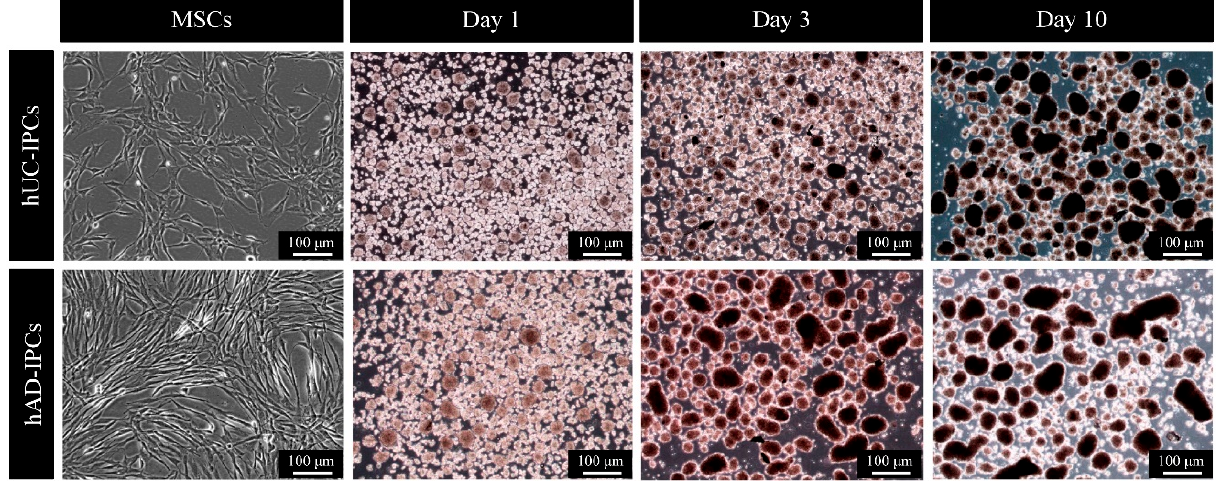
Figure 2. Induction of cultured hUC-MSCs and hAD-MSCs into IPCs using a modified insulin– transferrin–selenium protocol. IPCs differentiation were induced in three steps over 10-day. Each step was marked by a change in medium composition. The differentiation of IPCs from hUC-MSCs (hUC-IPCs) went from step 1 to step 3, as cells gradually attained a round shape. The differentiation of IPCs from hAD-MSCs (hAD-IPCs) resulted in a significantly larger cell size during step 2. In step 3, the cells showed a tendency to adhere together as they grew. Images of all fluorescently stained cells were acquired using a ×100 objective, and representative images are shown. Abbreviations: IPCs, insulin-producing cells; MSCs, mesenchymal stem cells; hUC-MSCs, mesenchymal stem cells derived from human umbilical cord tissue; hAD-MSCs, mesenchymal stem cells derived from hu- man adipose tissue; hUC-IPCs, insulin-producing cells from human umbilical cord-derived mesen- chymal stem cells; hAD-IPCs, insulin-producing cells from human adipose-derived mesenchymal stem cells.